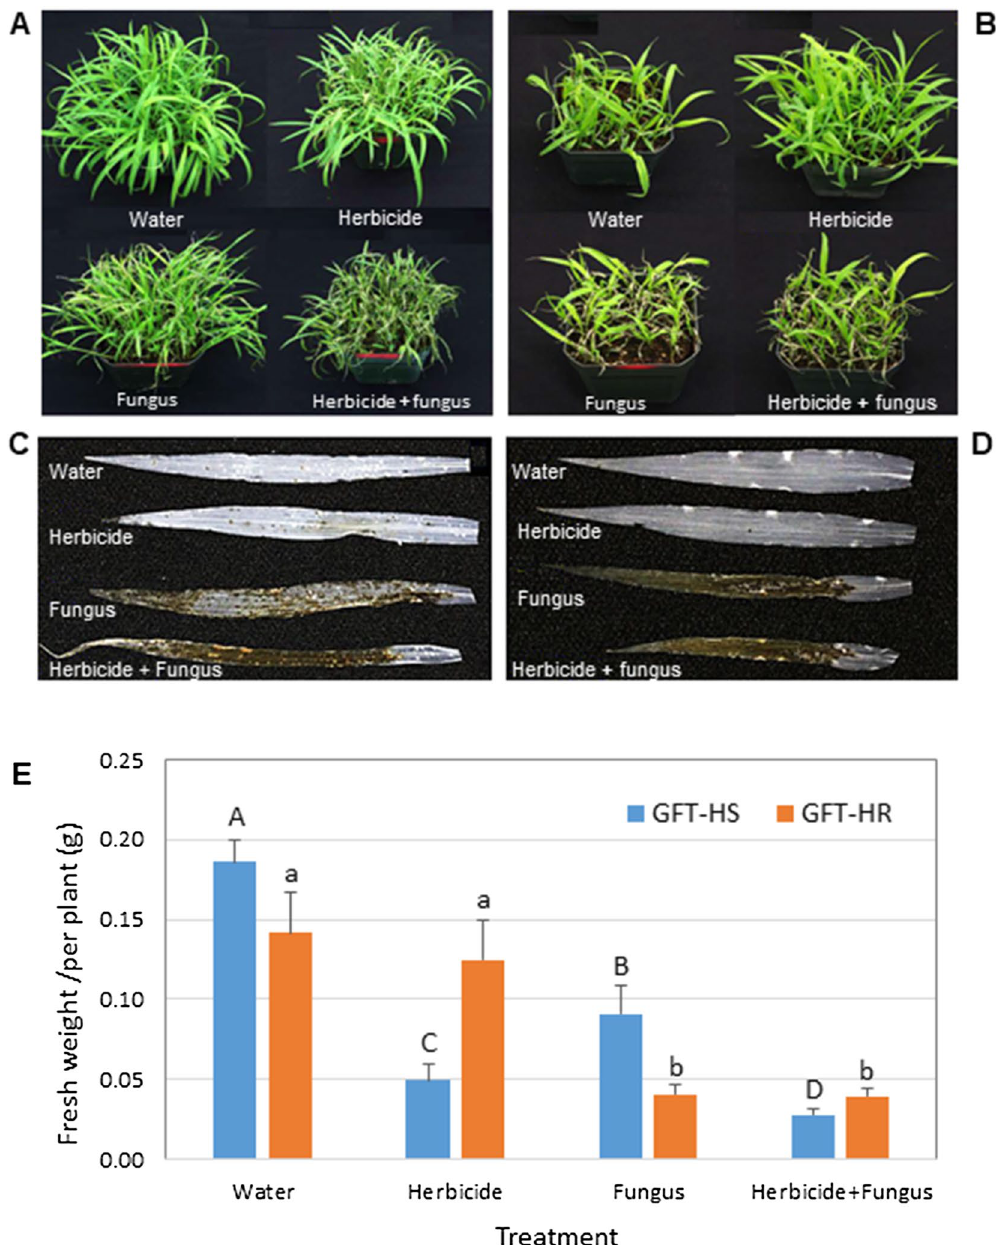
Figure 1. The herbicide sethoxydim at the 0.1 × recommended rate synergizes biocontrol of green foxtail by Pyricularia setariae (fungus). ( A ) The effect of herbicide, fungus or herbicide + fungus (synergy) treatment on herbicide-sensitive (HS) green foxtail (GFT) at 4 days post inoculation (dpi). ( B ) Effect of the same treatments on a herbicide-resistant (HR) GFT biotype at 4 dpi. ( C , D ) Infection severity on cleared leaves of GFT-HS and GFT-HR biotypes, respectively. ( E ) Fresh weight of variously treated green foxtail plants at 7 dpi. Means with the same capital (HS) or small (HR) letter did not differ (LSD, P <